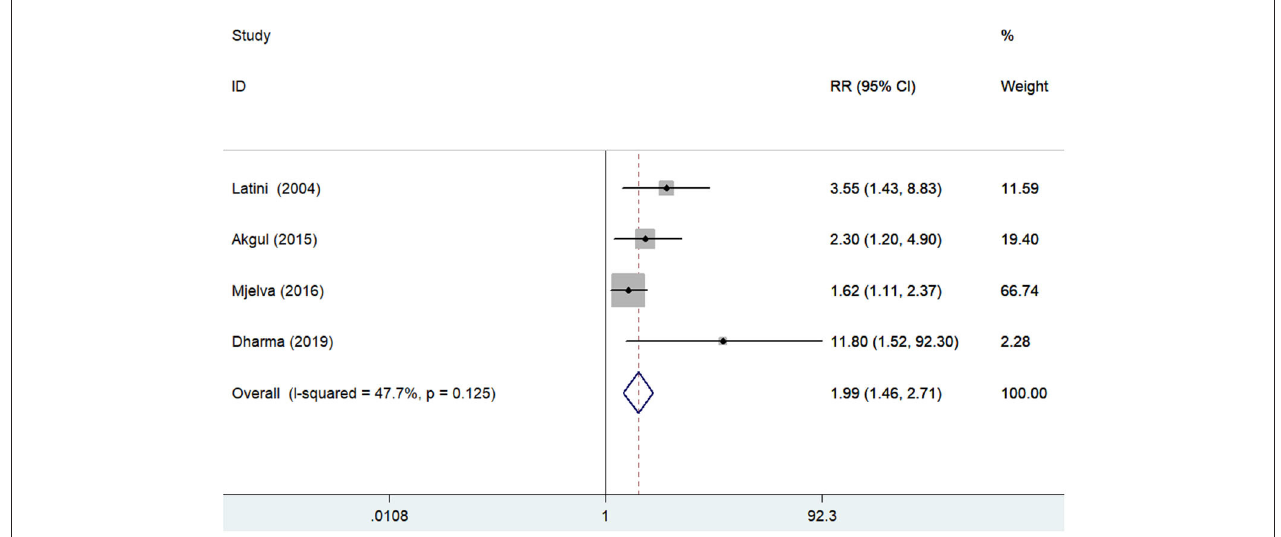
FIGURE 3 | Forest plots showing the pooled multivariate-adjusted RR and 95% CI of all-cause mortality for the highest pentraxin-3 level vs. the lowest pentraxin-3